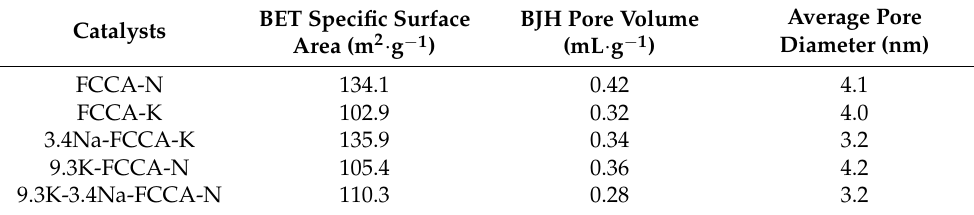
Table 1. Textural properties of K- and/or Na-promoted FCCA catalysts.